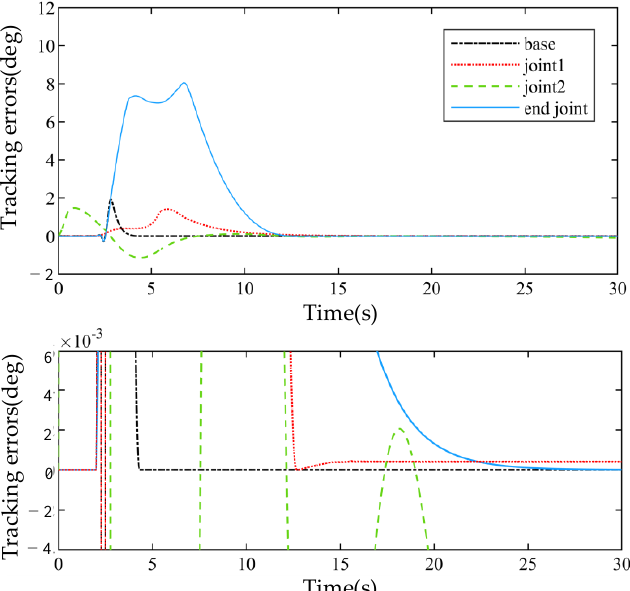
Figure 9. The trajectory tracking errors of base and 2-DOF joints.